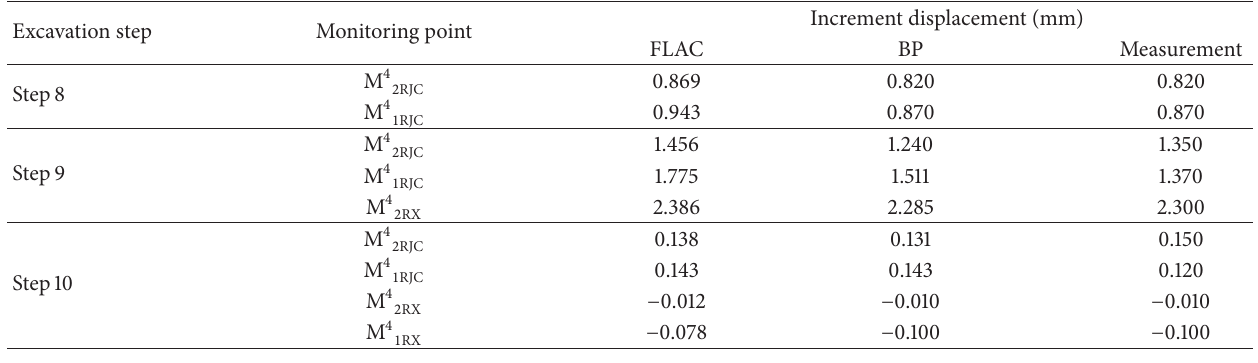
Table 5: Comparison of back analysis values, BP values, and measured values.